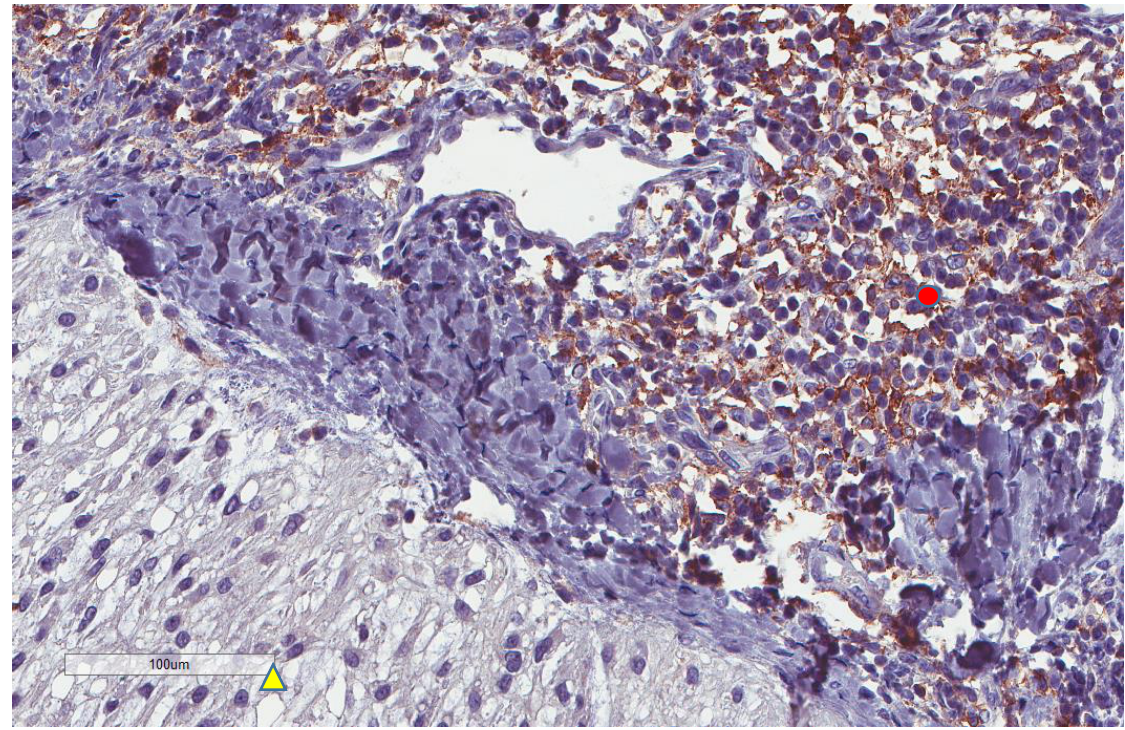
Figure 9. Representative image (×200 magnification) of another case showing that tumor cells (yellow triangle) do not express PD-L1, whereas nearby immune cells are PD-L1+ (red circle).